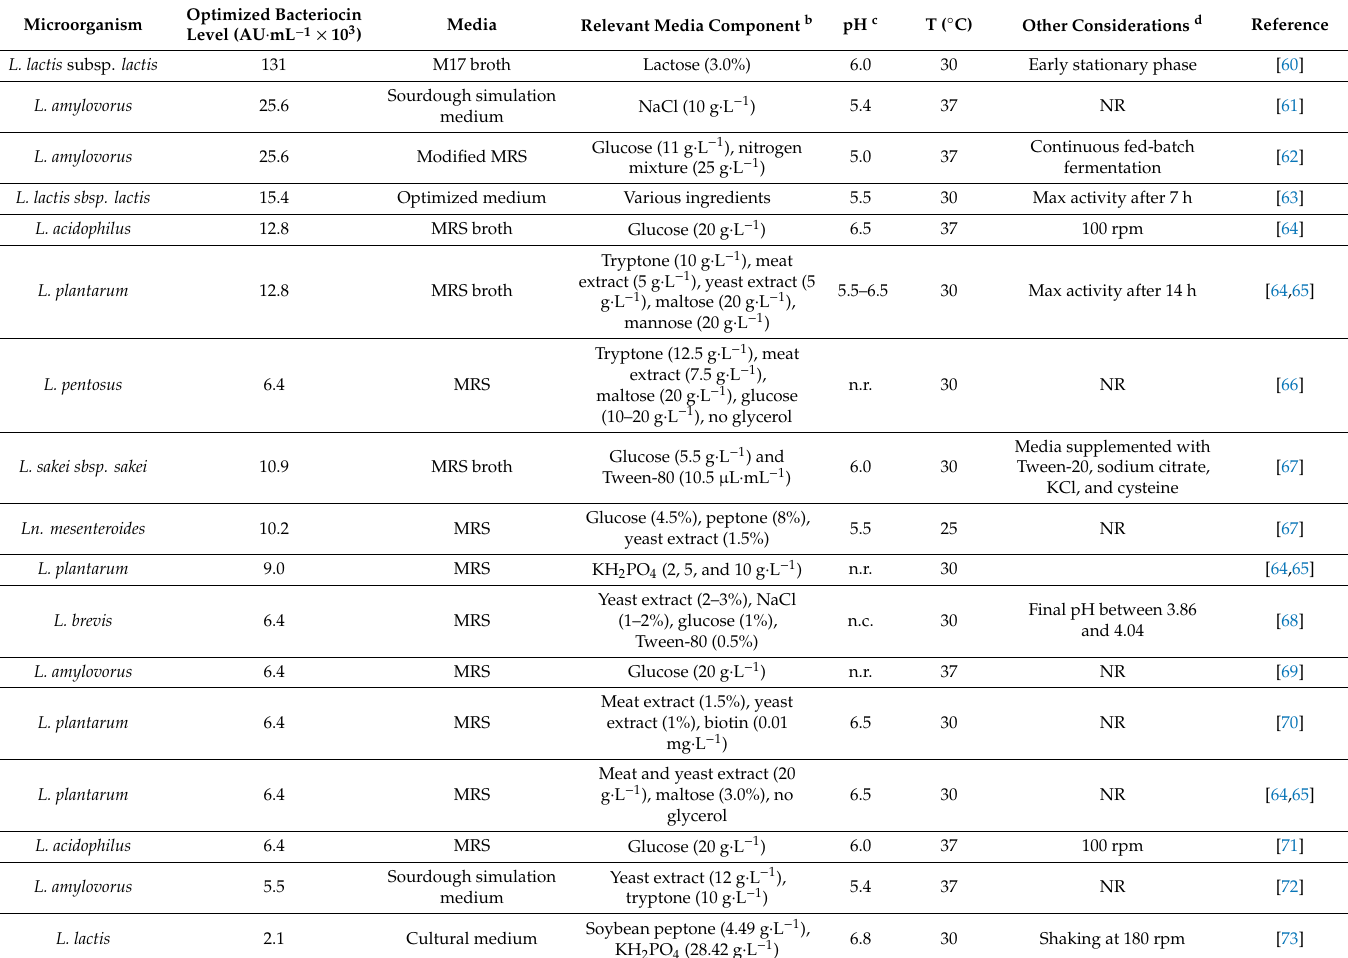
Table 1. Culture conditions necessary to attain high bacteriocin titers from Lactobacillus according to scientific literature a .